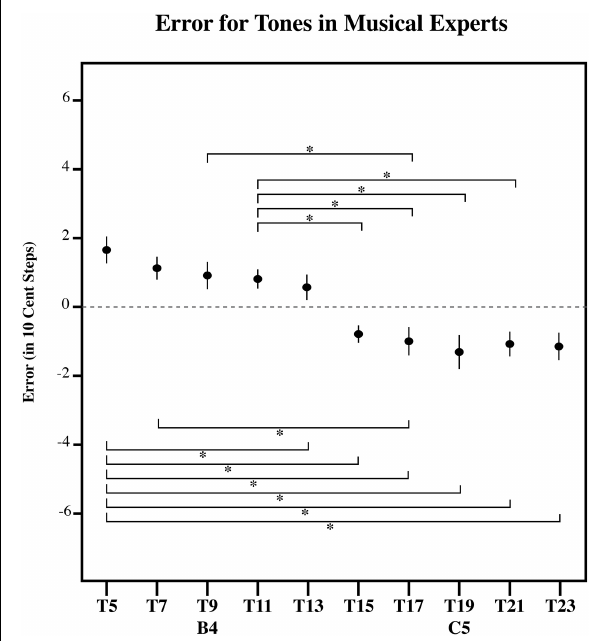
FIGURE 10 | The error in 10-cent steps for each tone in MN. Significant pairwise comparisons (alpha 0.05) using a Sidak adjustment are indicated with an asterisk. Note that MN bisect the presented distribution at its midpoint, such that lower tones in the series are overestimated and higher tones in the series are underestimated. However, note that MN ( Figure 10 ) has a flatter error patterns than the RGD ( Figure 11 ). Error bars represent ± 1